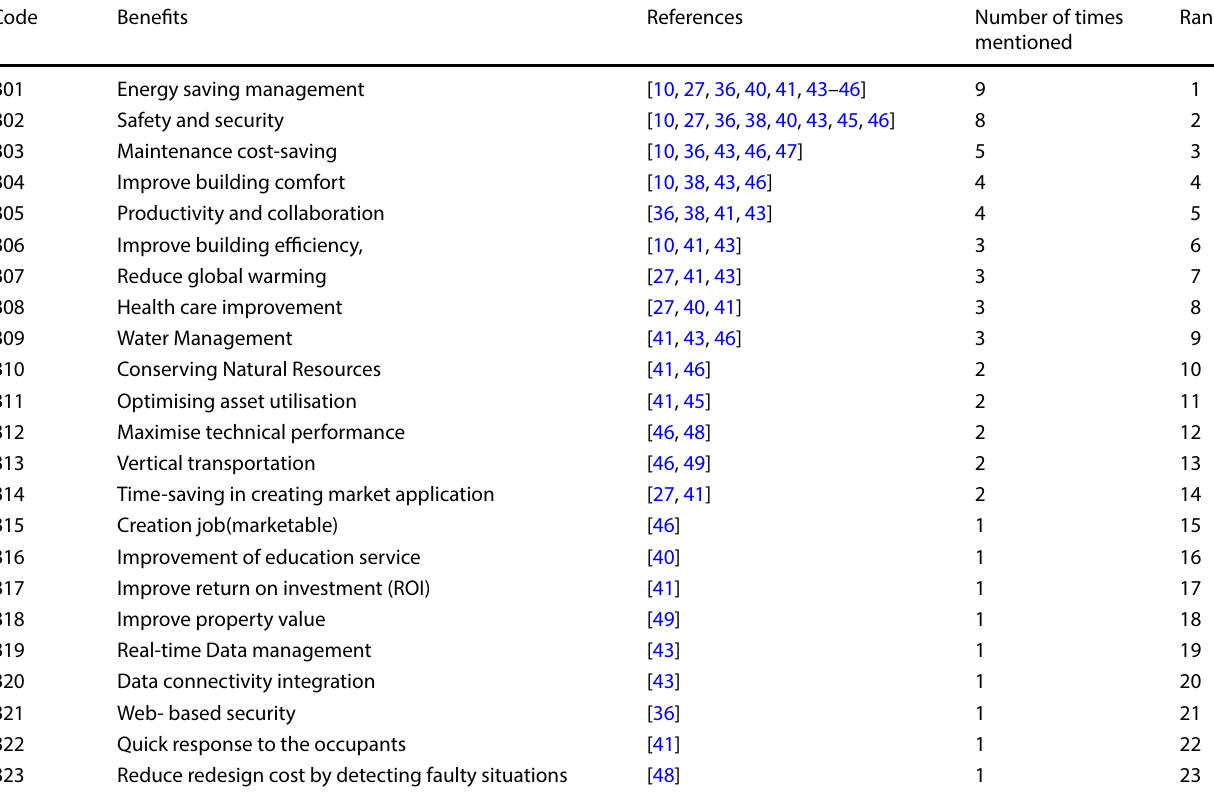
Table 1 The benefit of smart building technology Code